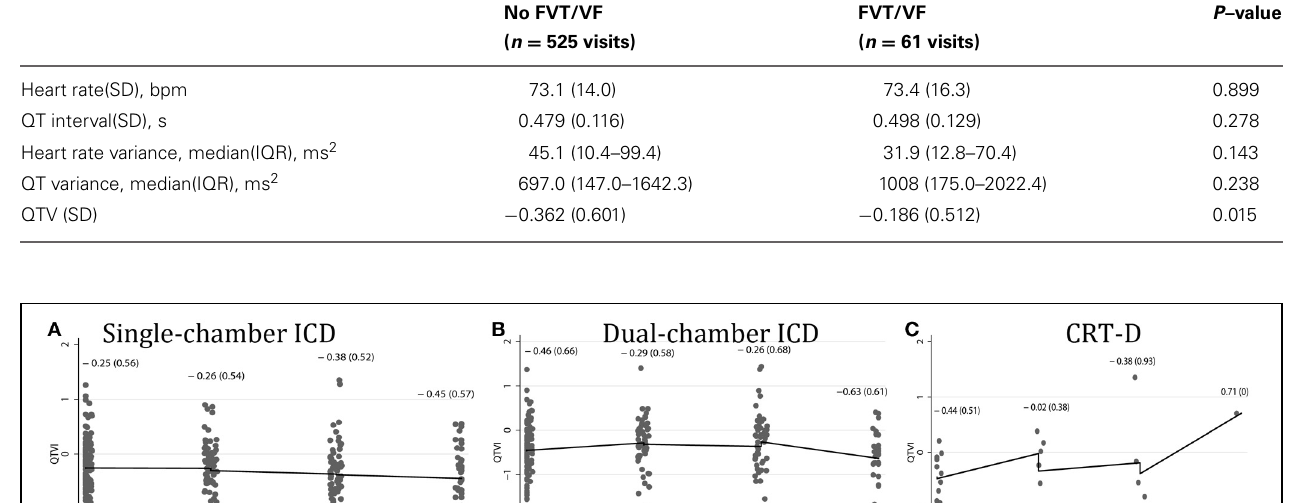
Table 4 | Comparison of all-visits averaged ECG parameters in patients with and without FVT/VF during follow-up.